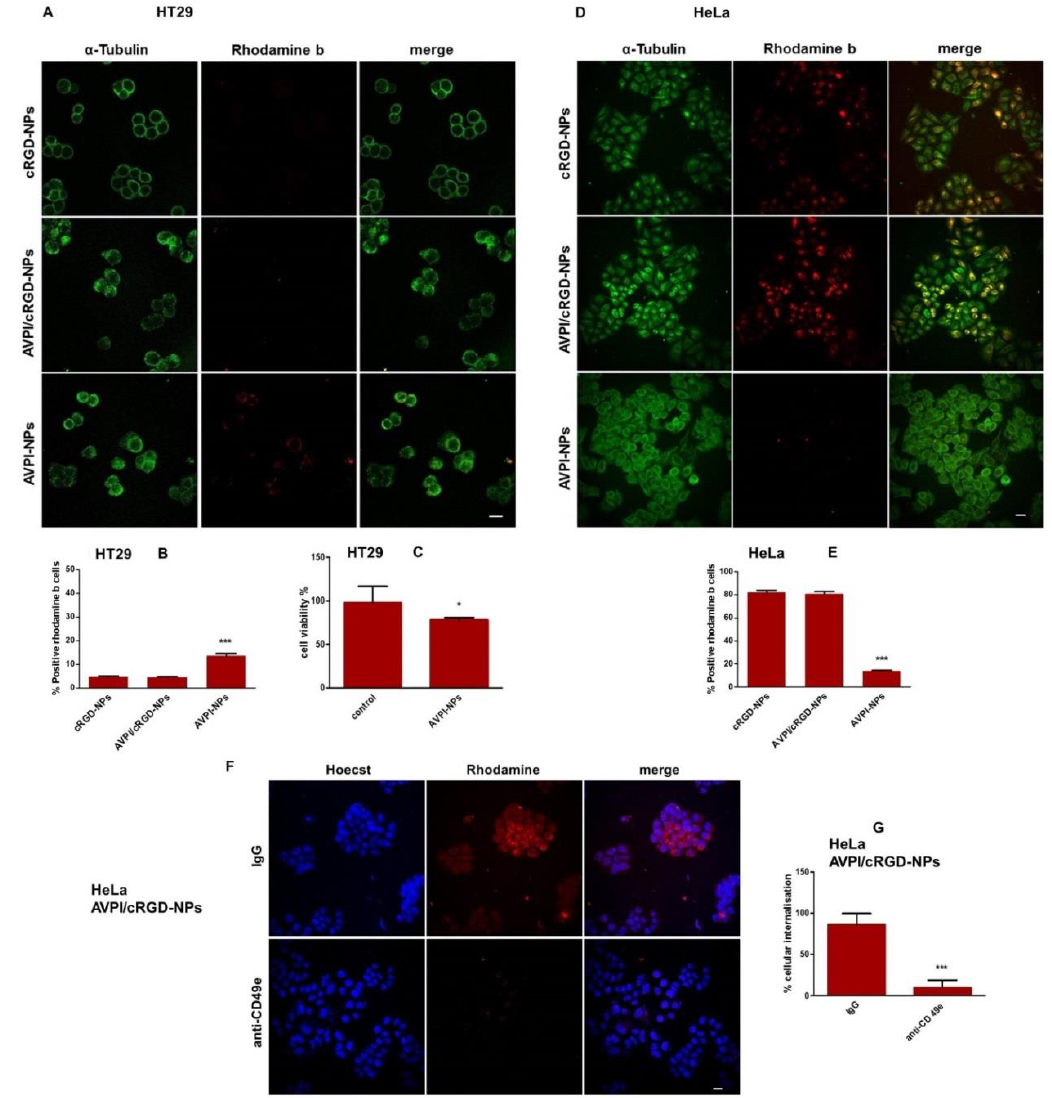
Figure 3. Fluorescence microscopy of cells after 1 h of treatment with fluorescent peptide–RhB–NPs (red), counterstained with anti α-tubulin antibody (green) to visualize the cytoskeleton. ( A ) HT29 cells. Photographs were taken at 60× magnification, bar = 20 µm. ( B ) RhB-positive HT29 cells %, error bars represent SD (n = 15 imaging fields), *** p < 0.001. ( C ) HT29 cell viability % in the presence of AVPI–NPs; data represent mean ± SD (n = 6). * p < 0.05. ( D ) HeLa cells. Photographs were taken at 40× magnification. Bar 20 µm. ( E ) RhB-positive HeLa cells %, error bars represent SD (n = 15 imaging fields), *** p < 0.001. ( F ) HeLa cells were treated or not with an anti-CD49e antibody or control IgG for 1 h, then incubated whit fluorescent AVPI/cRGD–NPs (red) and counterstained with Hoechst33342 dye (blue) to visualize the nuclei. Photographs were taken at 40× magnification. ( G ) HeLa cells internalization %, error bars represent SD (n = 15 imaging fields), bar = 20 µm, *** p < 0.001.